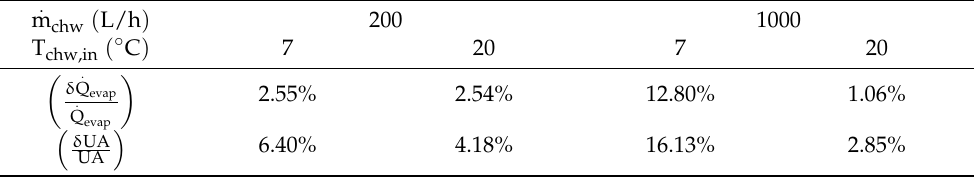
Table 3. Relative composed uncertainty average values for the evaporation process